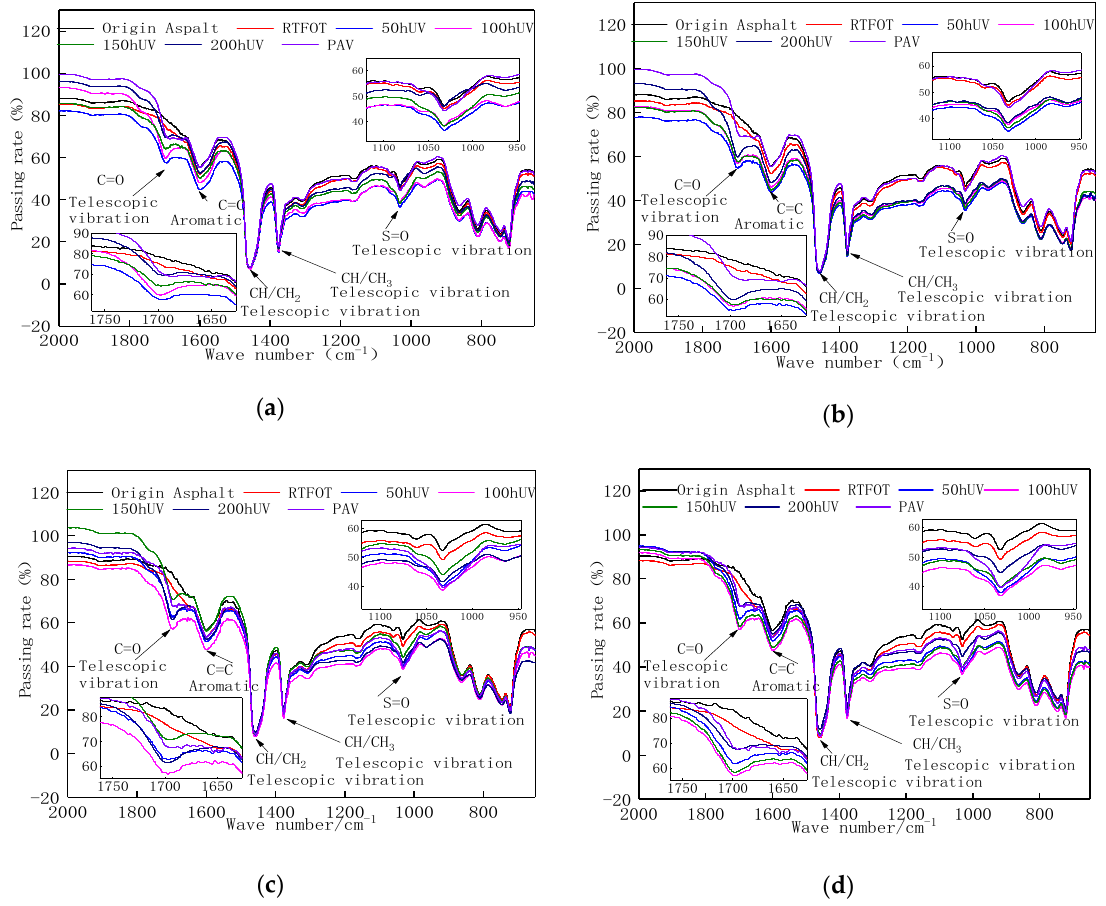
Figure 10. WMA’s infrared spectra before and after aging. ( a ) 0% E Isolation oxygen conditions. ( b ) 0% E oxygen-containing conditions. ( c ) 0.5% E Isolation oxygen conditions. ( d ) 0.5% E oxygen-containing conditions.